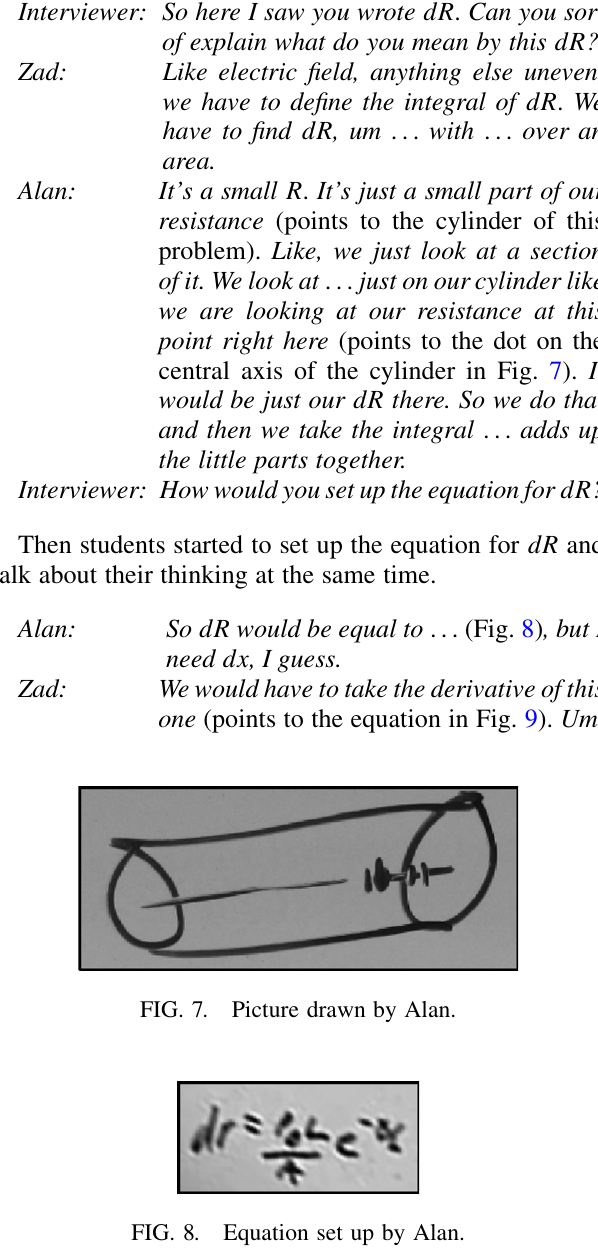
FIG. 10. Expression for dR .